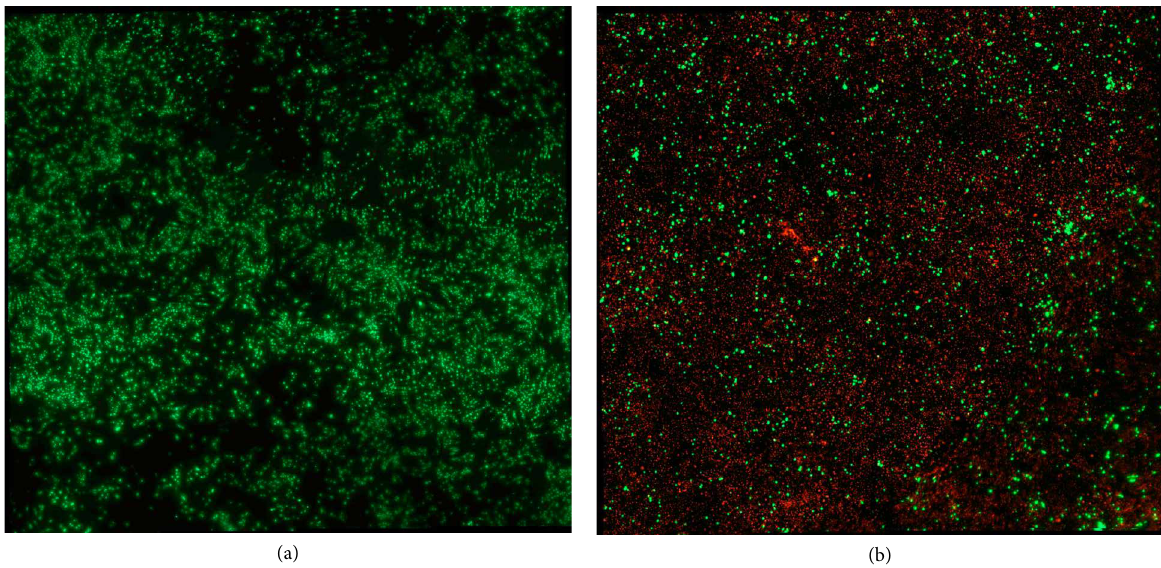
Figure 2: Fluorescent microscope images of the Live/Dead assay before (a) and after (b) the electrochemical treatment for 12 h at 퐸 = 1.0 V. The intracellular esterase activity by live cells is shown by the green fluorescent calcein dye. The loss of plasma membrane integrity of dead cells is shown by the red fluorescent ethidium homodimer. The calculated percentage of live cells before and after the electrochemical treatment is given in Table 1. Table 1: Live/Dead analysis of cells before and after treatment.